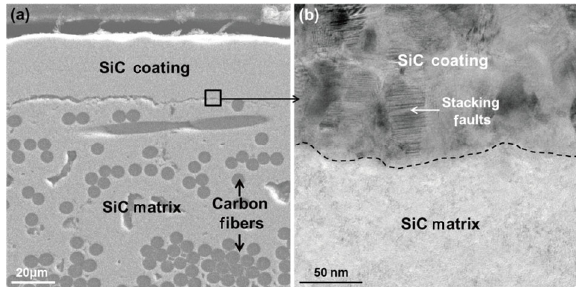
Fig. 1 (a) Cross-sectional microstructure of the as- fabricated C f /SiC in scanning electron microscopy; (b) crystalline microstructure at the coating/matrix interface by TEM